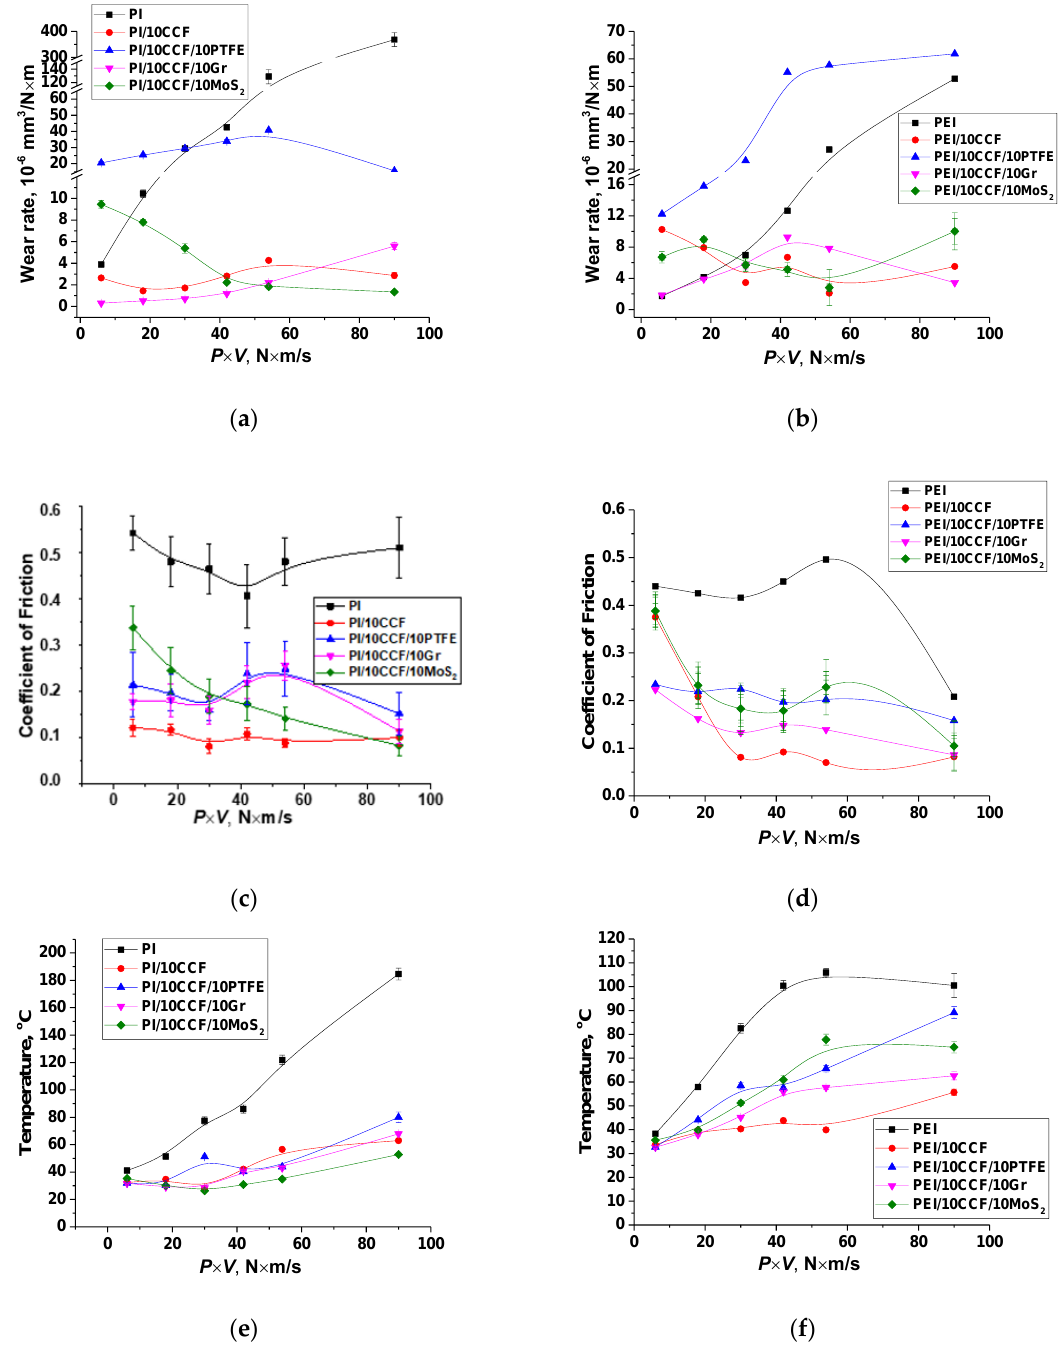
pattern of the effect of the solid lubricant fillers on the tribological properties of the composites relative to those for the ‘ball -on- disk’ scheme [44], when loading with PTFE was very low (~0.12 under the ‘mild’ conditions and ~0.1 under the ‘severe’ ones, Figures 2f provided the maximum wear resistance. and 3f, respectively). In general, the mechanism of the TF formation on the counterpart, as